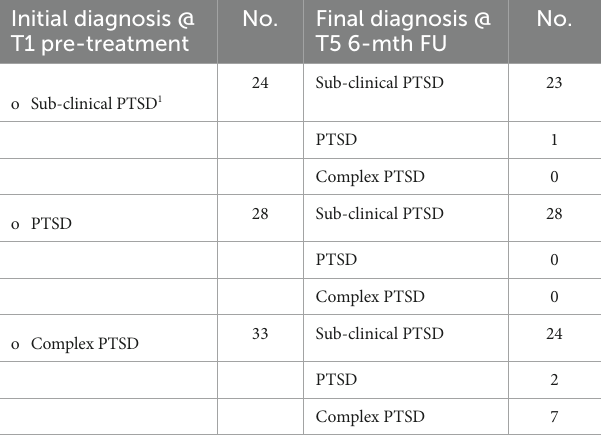
TABLE 5 Changes in clinical diagnosis following VGTEP intervention using the ITQ at T1 and T5 ( N = 85). Initial diagnosis @ T1